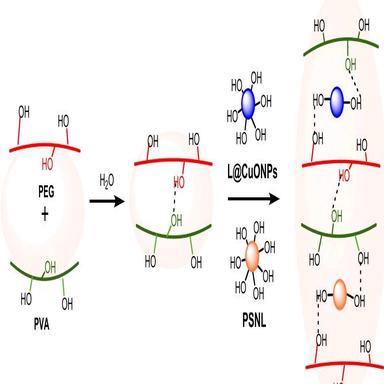
Monitoring shelf-life of bananas from Day 0–15: unpacked (on the left side of each petriplate) and packed in PVA-PEG-10%PNSL-5%L@CuONPs nanocomposite (on the right side of each petriplate).